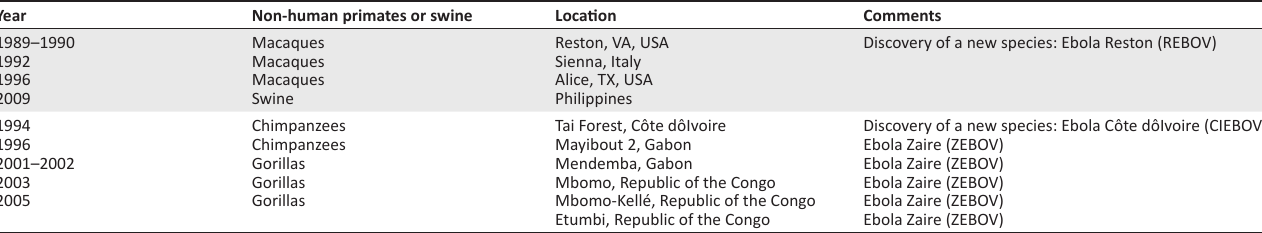
TABLE 2: Documented outbreaks of Ebola virus amongst non-human primates and swine (1980–2005) in Africa. Year Non-human primates or swine